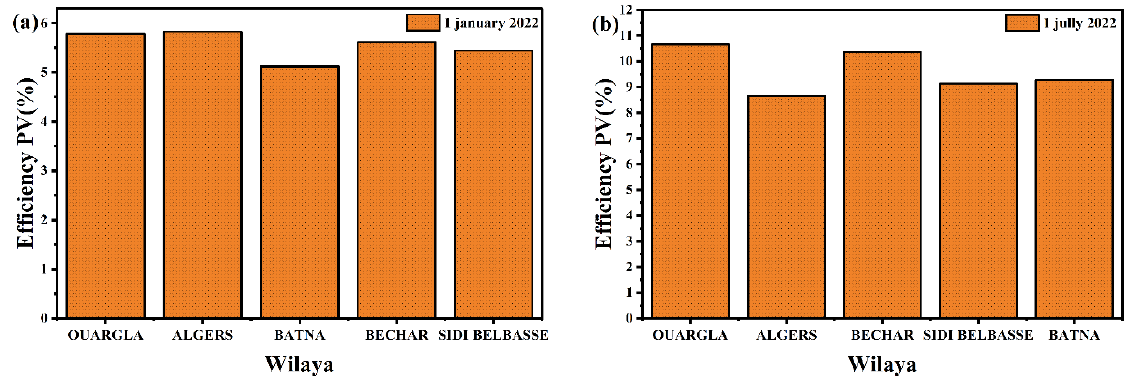
Figure 4. Daily PV efficiency at different sites in Algeria on ( a ) 1 January and ( b ) 1 July 2022. This results is signified by geographic and climate data which favour the site of